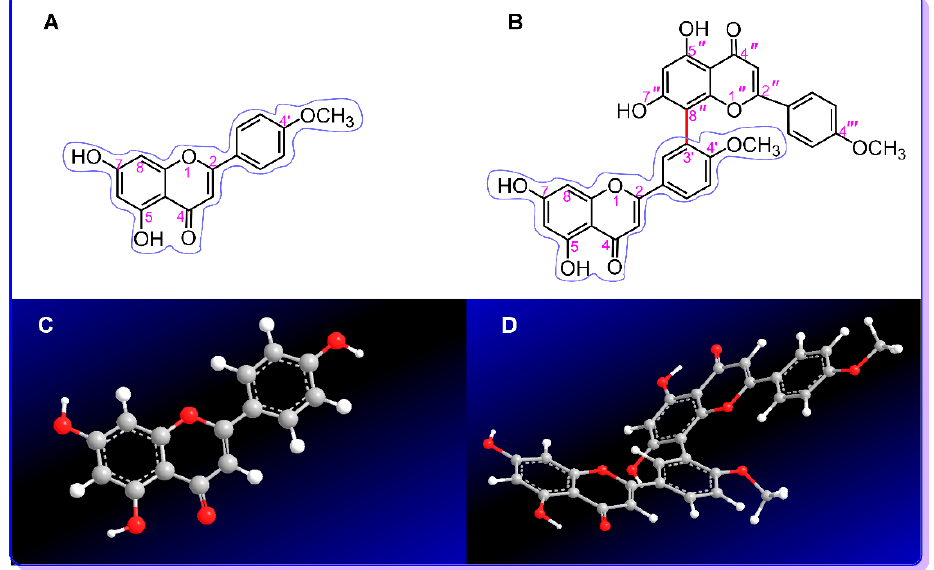
Figure 1. The structures and molecular models of acacetin and isoginkgetin: ( A ) structure of acacetin; ( B ) structure of isoginkgetin; ( C ) molecular model of acacetin; ( D ) molecular model of isoginkgetin. The molecular model was created based on the preferential conformation by using the Chem3D Pro 14.0 program (PerkinElmer, Waltham, MA, USA). The molecular model D has a dihedral angle of 45°,